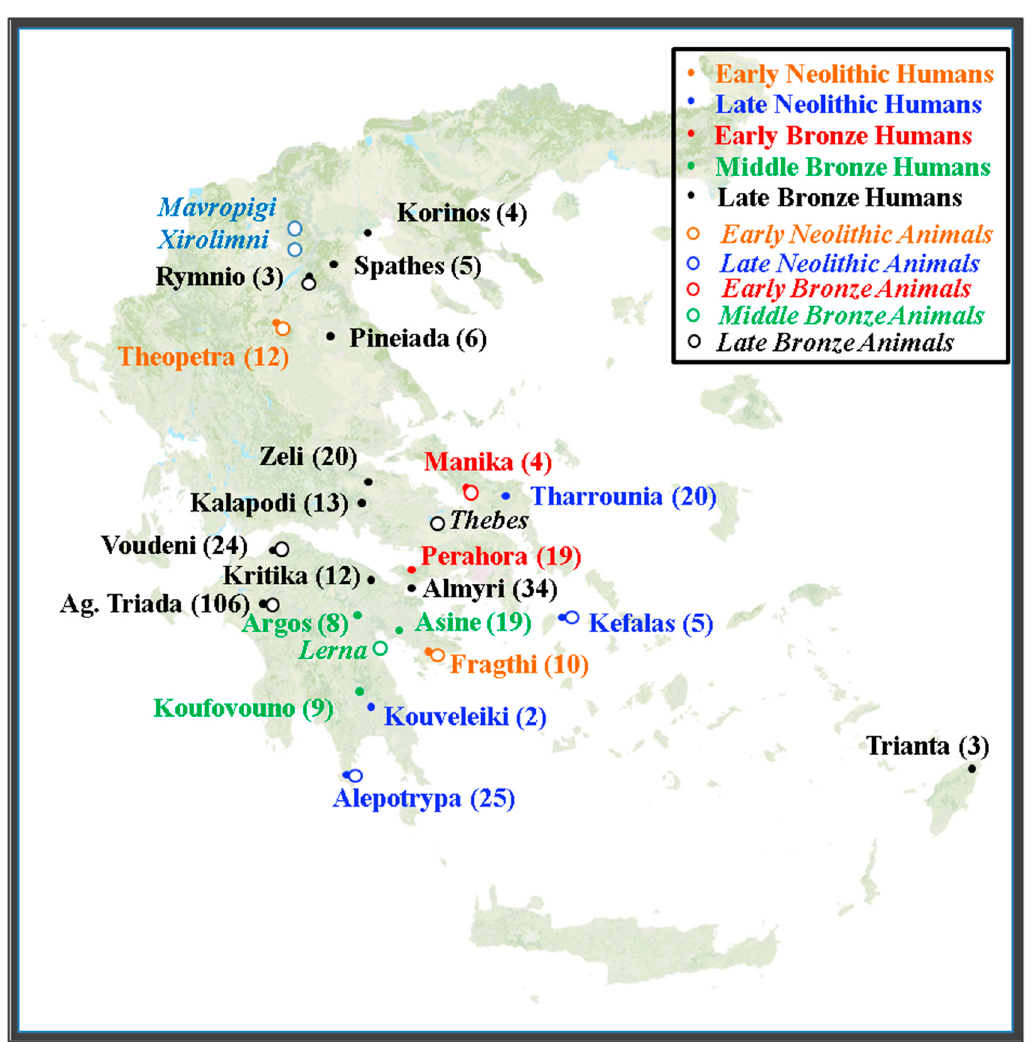
Figure 1. Spatial distribution of human and fauna sites. Solid circles and the sites names in regular are human sites while hollow circles and the sites names in italics are fauna sites of the same or nearby areas of the respective time periods. The numbers in parenthesis denotes the number of human samples in each site.